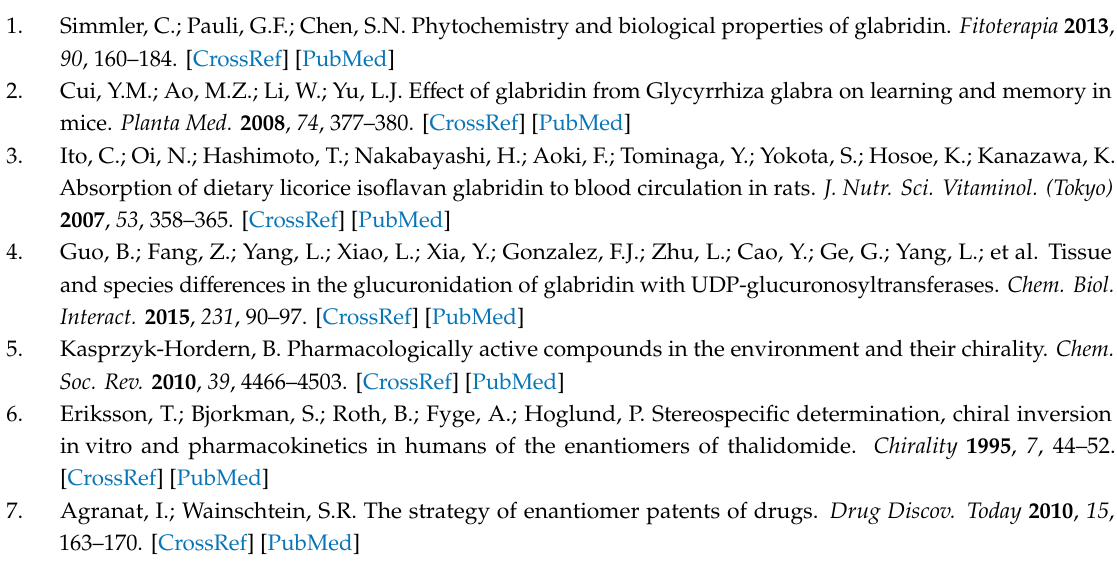
Figure S1: Representative chromatograms of HSG4112(S) and HSG4112(R) in (A) rat (oral, 100 mg / kg, 6h) and (B) dog (oral, 100 mg / kg, 6h) plasma, Figure S2: Proposed chemical structures of HSG4112 metabolites, Figure S3: Postulated metabolic pathways of HSG4112 isomers, Table S1: Blood drain time points for oral pharmacokinetic analysis in rats (repeated dose, 100 mg / kg / day, 28th day), Table S2: Linearity of HSG4112(S) and HSG4112(R) in rat plasma ( n = 3), Table S3: Intra-day and inter-day accuracy and coe ffi cient of variation for determination of HSG4112(S) and HSG4112(R) in rat plasma, Table S4: Matrix e ff ect, recovery and process e ffi ciency data for HSG4112(S) and HSG4112(R) in rat plasma ( n = 3), Table S5: Stability of HSG4112(S) and HSG4112(R) in rat plasma, Table S6: Linearity of HSG4112(S) and HSG4112(R) in dog plasma, Table S7: Intra-day and inter-day accuracy and coe ffi cient of variation for determination of HSG4112(S) and HSG4112(R) in dog plasma, Table S8: Matrix e ff ect, recovery and process e ffi ciency data for HSG4112(S) and HSG4112(R) in dog plasma ( n = 3), Table S9: Stability of HSG4112(S) and HSG4112(R) in dog